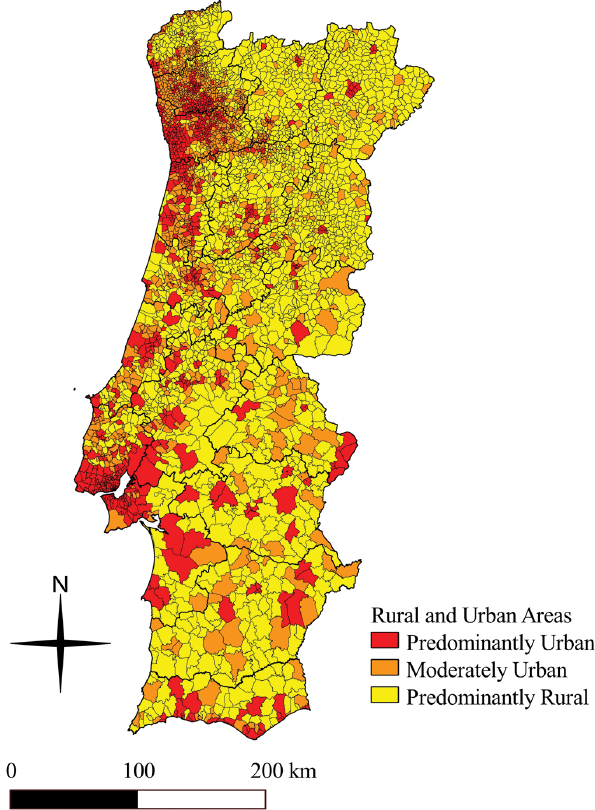
Fig. 3. Urban area types in Portugal (predominately urban, mod- erately urban, predominately rural) given spatially by principal ad- ministrative regions: 18 districts (see Fig. 2 for names), 278 munic- ipalities (counties), and 4050 parishes in 2008. Data from Statistics Portugal (2011), who give detailed definitions for the different ur- ban types and shape file from IGEO